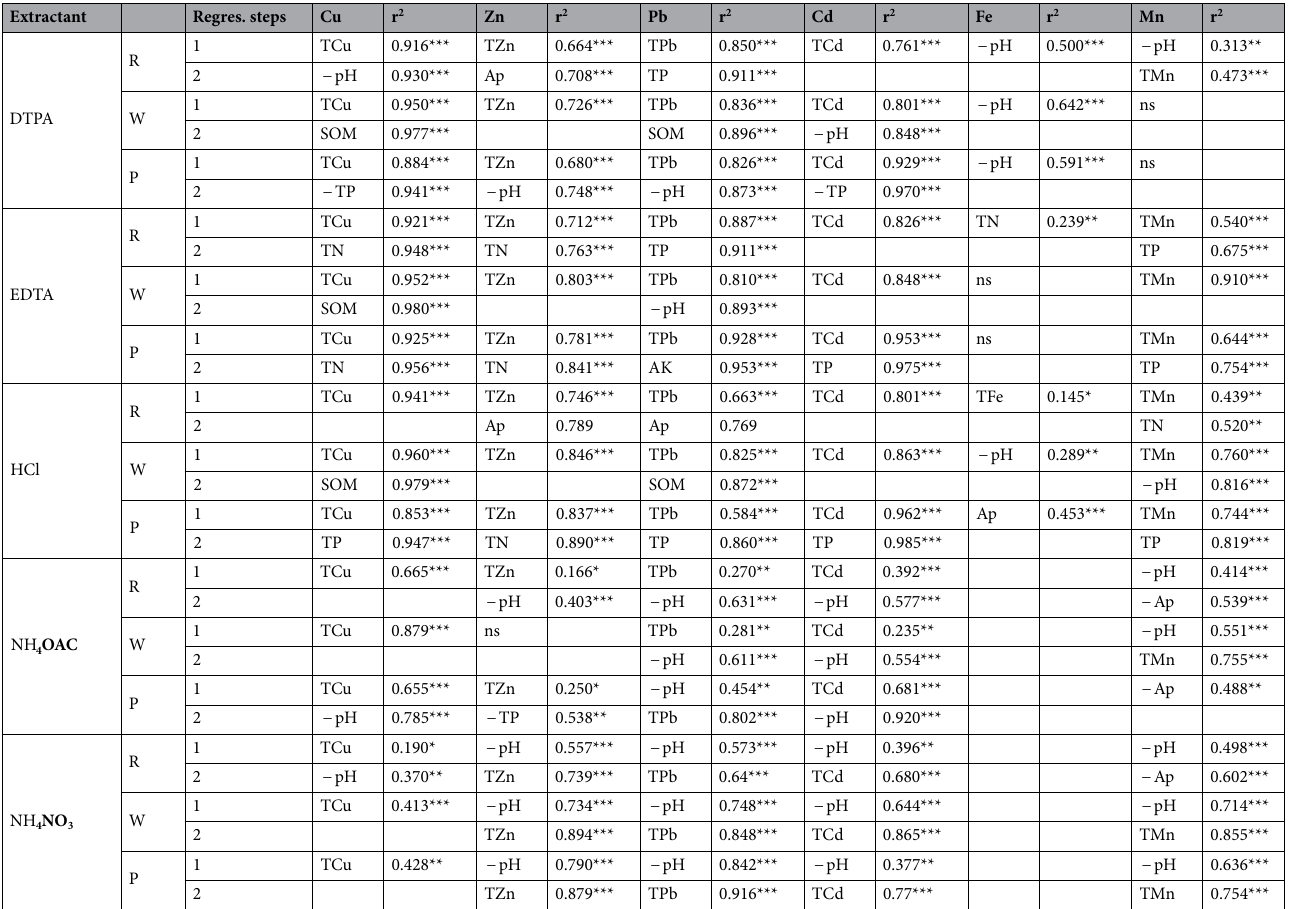
Table 4. Stepwise multiple regressions between soil extractable metals and soil properties (including soil total metals). TCu total Cu, TZn total Zn, TPb total Pb, TCd total Cd, TFe total Fe, TMn total Mn. ***, ** and * indicate significant correlations at the probability level of p < 0.001, p < 0.01 and p < 0.05, respectively, ns not